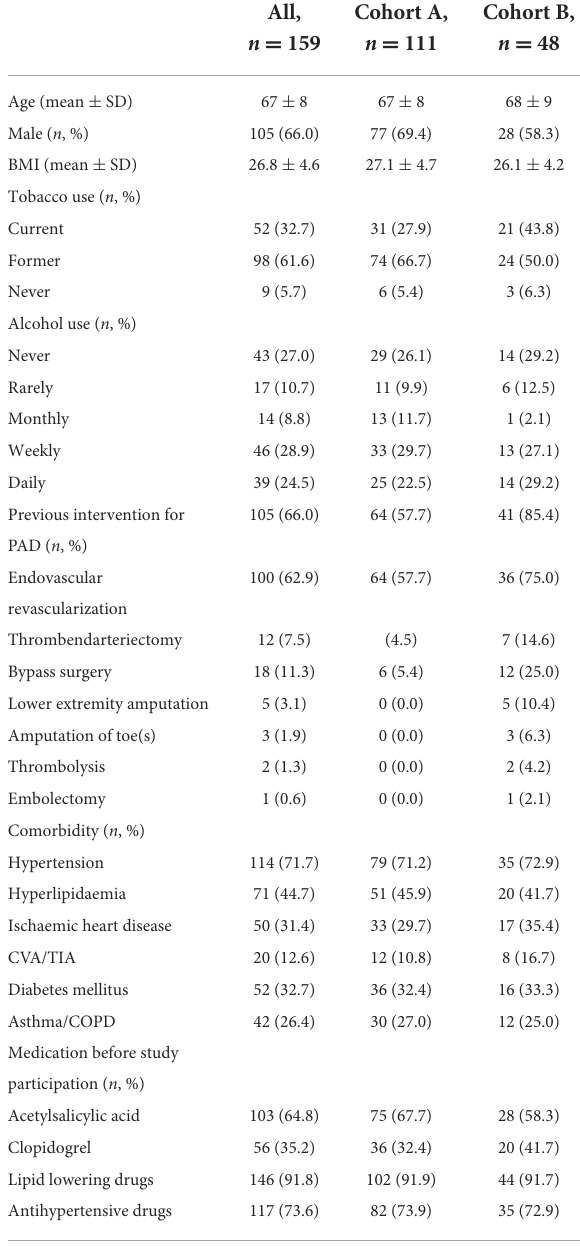
The mean plasma ET-1 levels at T1 and T2 did not differ TABLE 1 Baseline characteristics of the patients that successfully completed the run-in period. significantly and were 1.70 ± 0.57 vs. 1.66 ± 0.64 pg/mL ( p = 0.440) for the total group, 1.69 ± 0.59 vs. 1.62 ± 0.55 pg/mL ( p All, Cohort A, Cohort B, = 0.2 02) for cohort A, and 1.73 ± 0.53 vs. 1.77 ± 0.82 pg/mL ( p n = 159 n = 111 n = 48 = 0.6 82) for cohort B (Table 3). 28 (58.3)